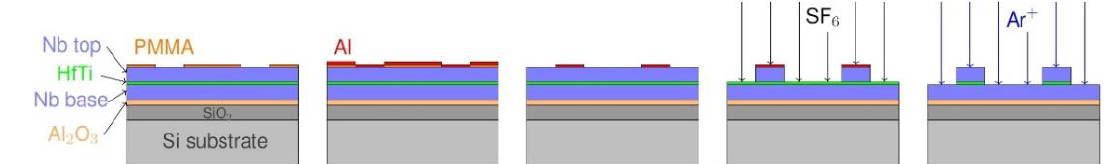
Figure 1. Layer scheme of the sub-µm range superconducting quantum interference device (nanoSQUID) fabrication process to define the Josephson junctions (JJs). After magnetron sputtering deposition (MSD) of the Al 2 O 3 etch stop layer and the Nb-HfTi-Nb trilayer, the Al hard mask is patterned by a positive resist mask and a subsequent lift-off process and the Nb top layer of the trilayer is etched with inductively coupled plasma reactive ion etching (ICP RIE) using SF 6 . Subse-